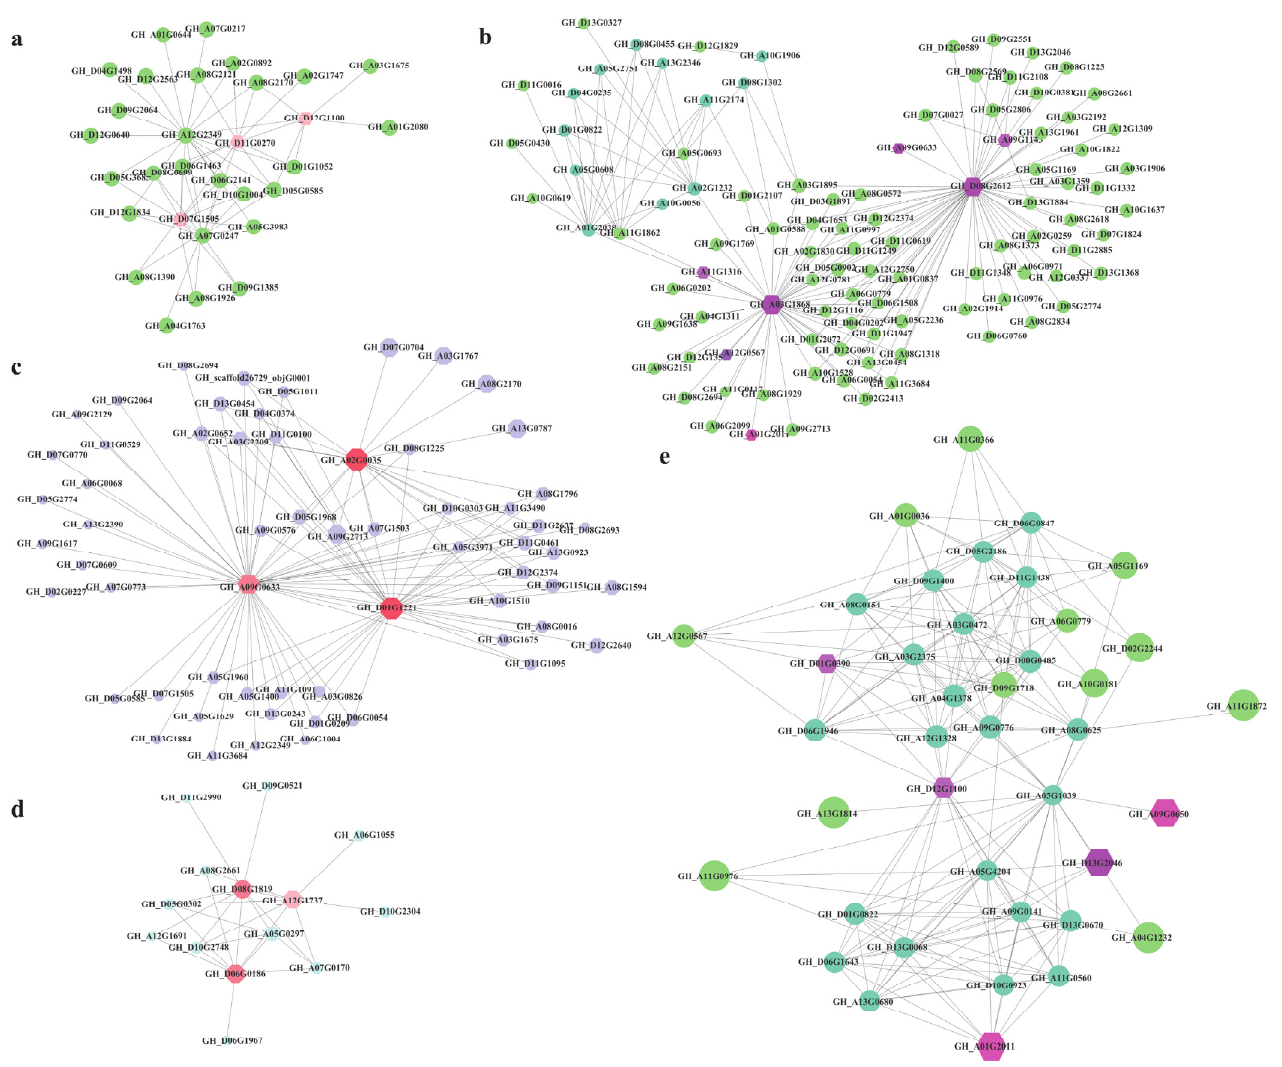
Figure 4. Gene networks of hub genes for significant co-expression modules. The genes with higher connectivity in the corresponding networks are shown with larger circle sizes. The size of the node circle is positively correlated with the degree of genes that it partners in interaction. ( a ), The PEG stress-related co-expression network genes in the blue module. ( b ), The PEG stress-related co-expression network genes in turquoise module. ( c ), The salinity stress-related co-expression network genes in the blue module. ( d ), The salinity stress-related co-expression network genes in the brown module. ( e ), The salinity stress-related co-expression network genes in the turquoise module.